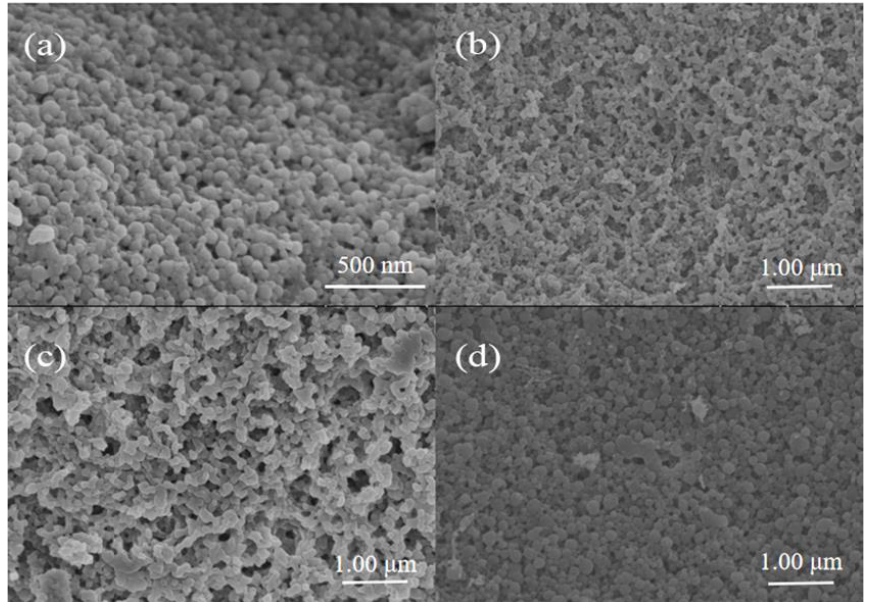
Figure 3. Microscopic morphology of different complex nanoparticles. ( a ) Zein-EGCG complex nanoparticles; ( b ) E-Z/G 1:1 complex nanoparticles; ( c ) E-Z/G 5:1 complex nanoparticles; ( d ) E-Z/G 2:3 complex nanoparticles.